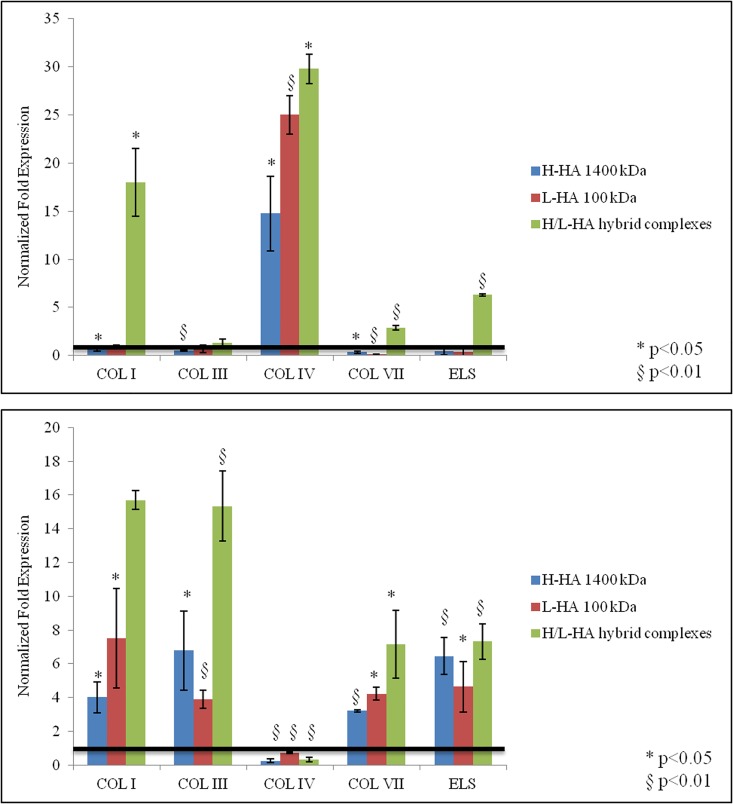
qRT-PCR analysis of COL I, COL III, COL IV, COL VII and elastin mRNA expression on FT skin model.Gene expression analysis in FT skin model was expressed as normalized fold expression respect to housekeeping gene and FT untreated model PBS injected (used as negative control), at 24h (A) and 7 days (B).